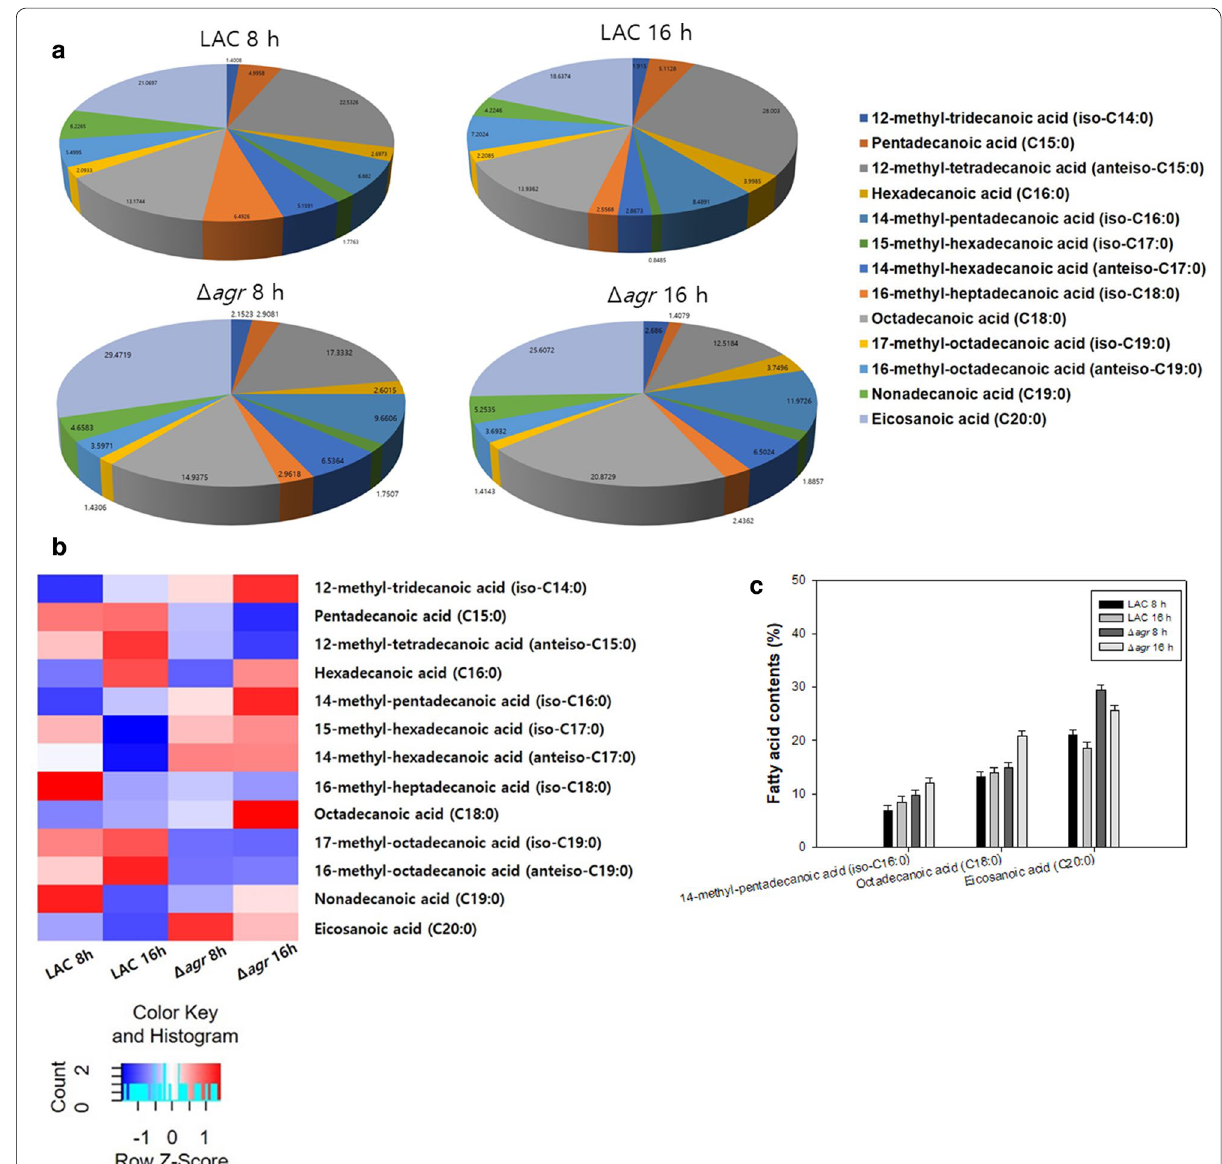
Fig. 3 Comparison of phospholipid fatty acids in the LAC and Δ agr mutant strains. a Compositional analysis of membrane fatty acids at different time points shown as a pie chart. b Compositional analysis of membrane fatty acids at different time points shown as a heatmap. c Fatty